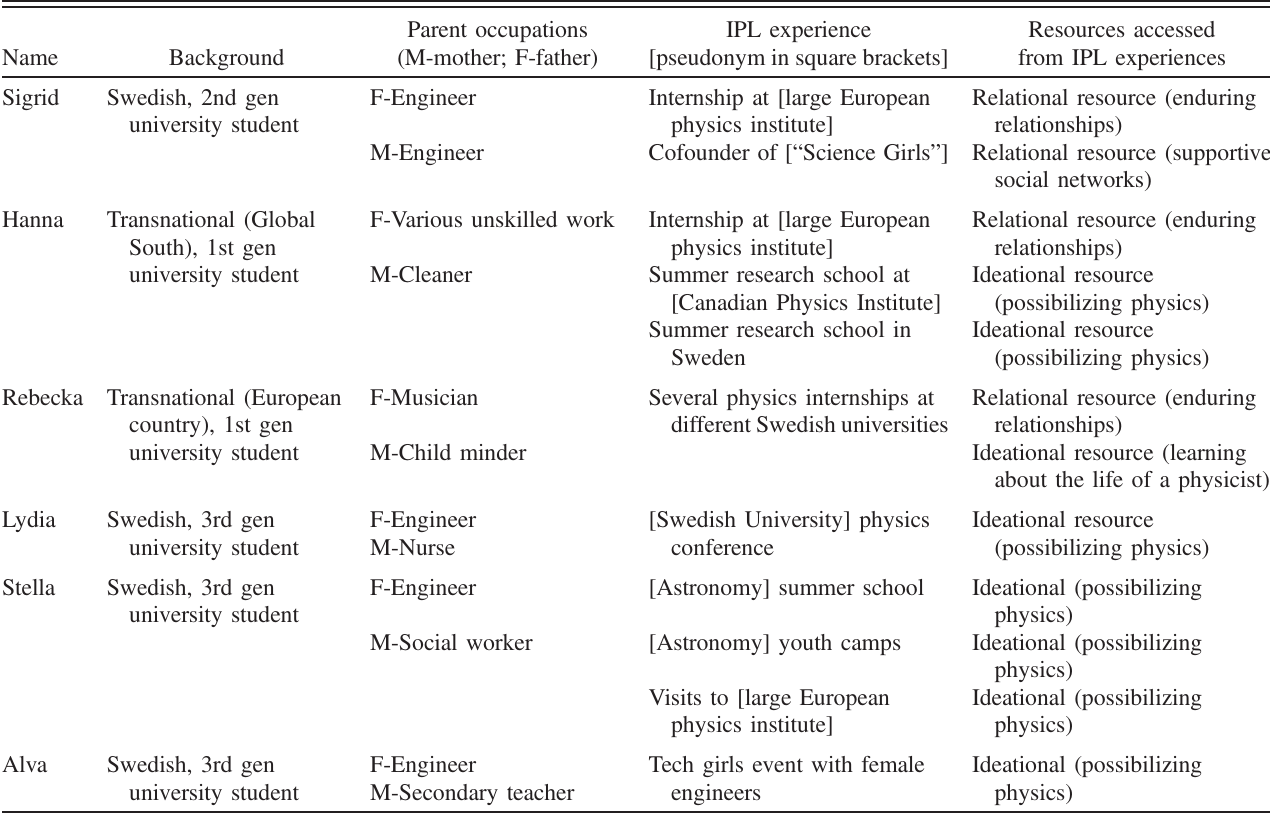
TABLE I. Participant